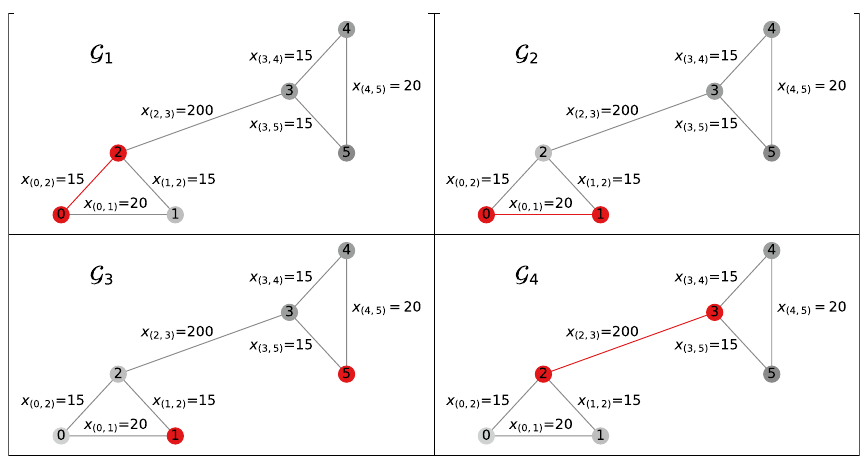
Fig. 3 Consider a symmetric graph G 0 with reactances x ( v , w ) and without resistances. Above figures show different first iteration choices of the weighted Clauset-Newman-Moore Algorithm into graphs G i , i 1,2,3,4 marked in red. Due to the symmetry of G 0 , other than the displayed choices for the fist iteration ∈ { } are equivalent. Without clustering, each node in G 0 can be interpreted as a singleton cluster, yielding the 0.1677 . For the four displayed cases, we calculate: initial modularity of Q 0 ≈ −